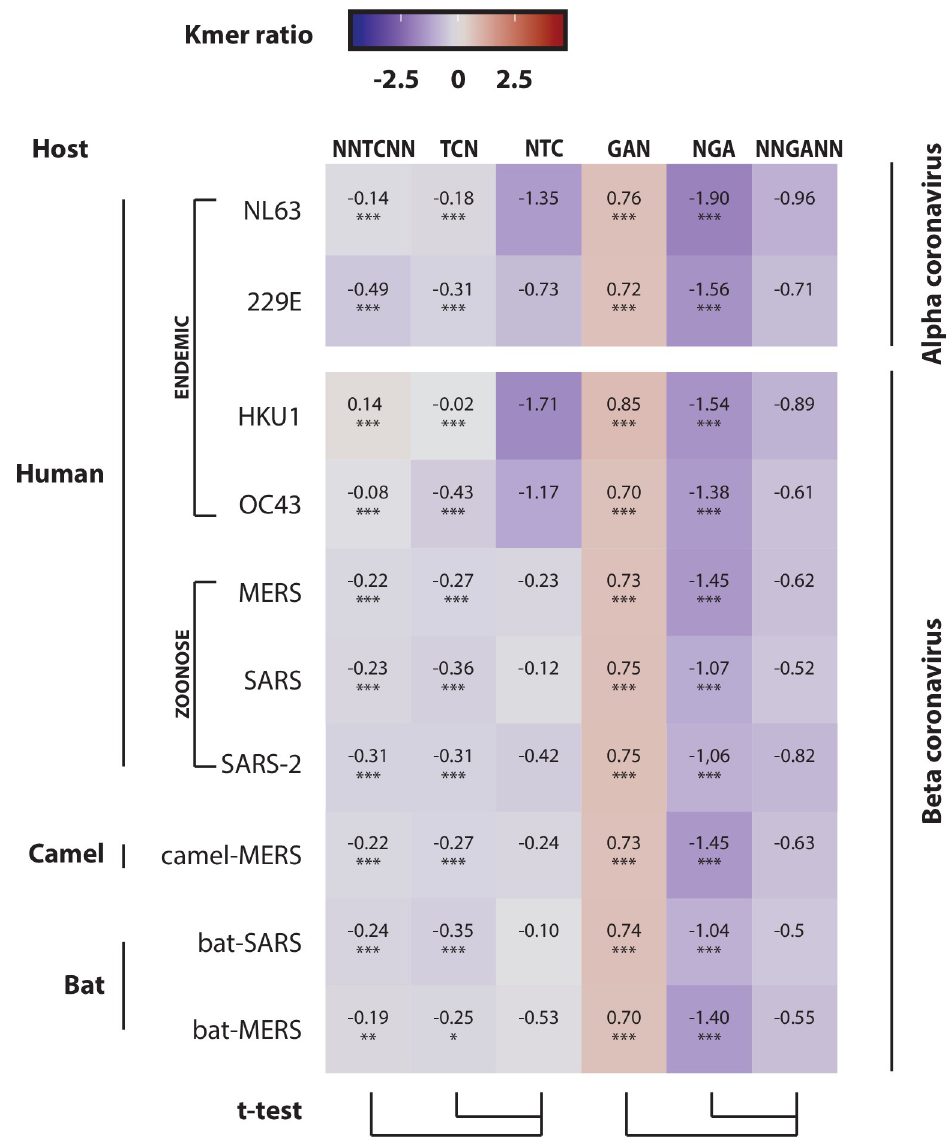
Fig 6. A3 footprint on endemic but not on zoonotic coronaviruses. The observed/expected ratios of TC dinucleotide at various codon positions were calculated for endemic human coronaviruses (229E, NL63, OC43 and HKU1) and compared to those of zoonotic coronaviruses (MERS-CoV, SARS-CoV-1 and SARS-CoV-2) and their ancestors (camel-MERS and bat-SARS). A colored scale with increasing shades of blue indicating depletion and increasing shades of red indicating enrichment. P-values were calculated by Student’s unpaired, two-tailed t-test (NS for not significant, � p < 0.05, �� p < 0.01, ��� p <